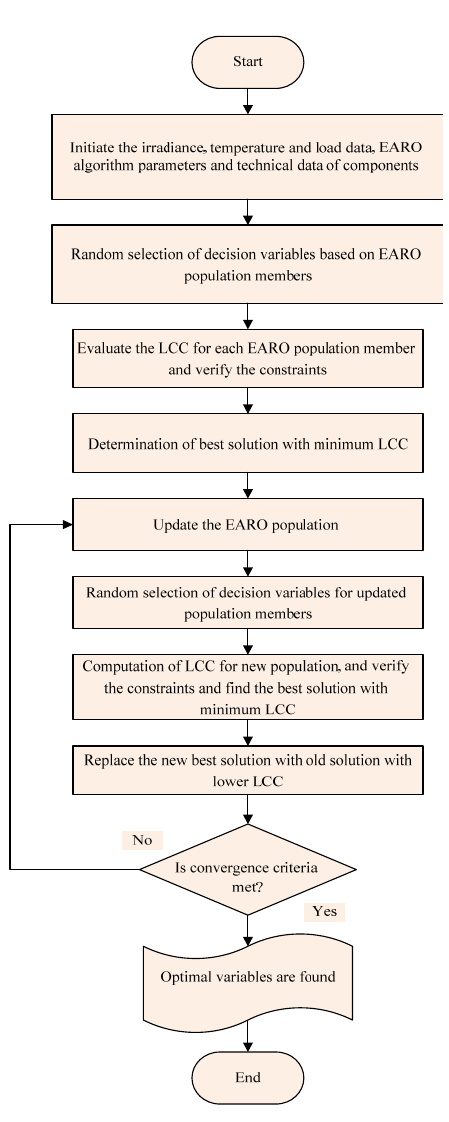
Figure 4. Flowchart of the EARO implementation for sizing problem solving . Figure 3. Flowchart of the EARO implementation for sizing problem